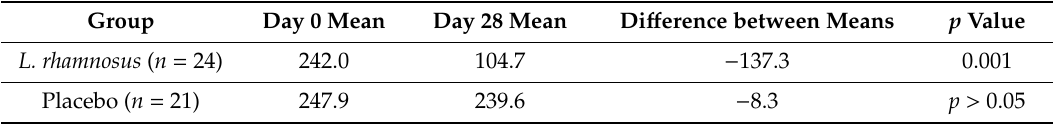
Table 2. Crying and fussing time (mean minutes per day) in the L. rhamnosus and placebo group at Day 0 and Day 28. Group